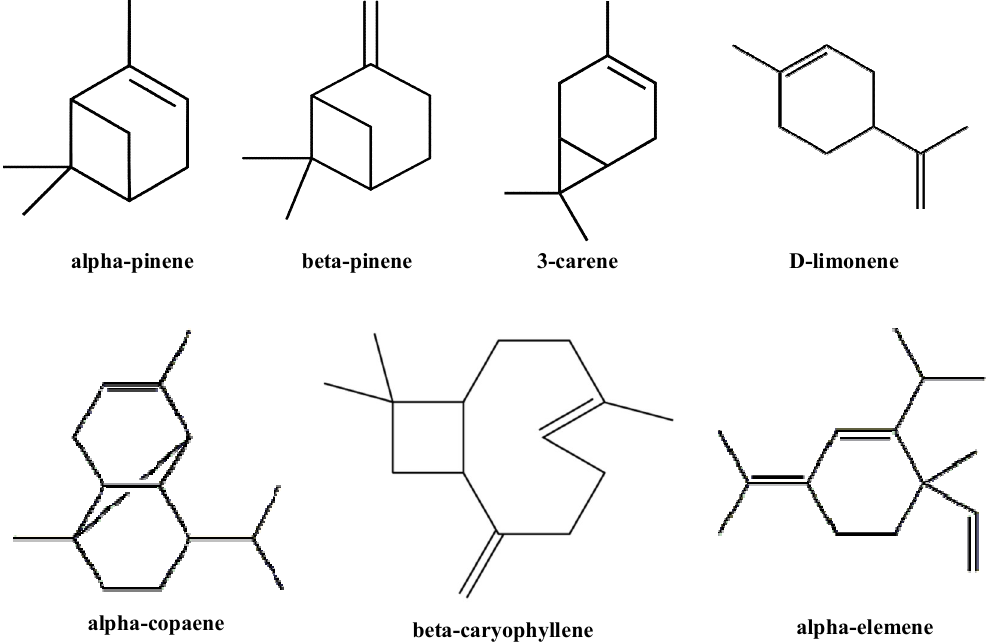
Figure 12. Major components of black pepper essential oil.